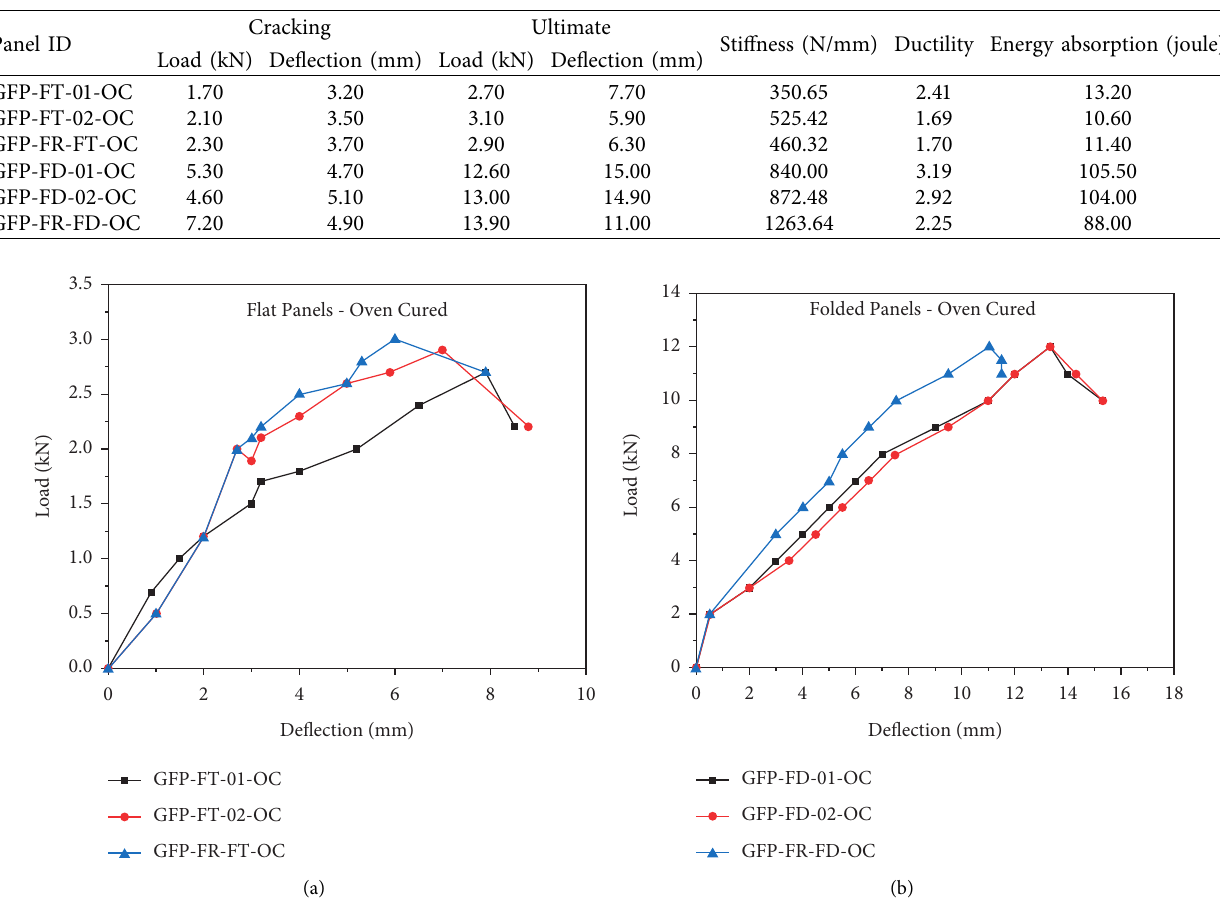
Figure 12: Load-deflection of GF panels. (a) Flat panels. (b) Folded